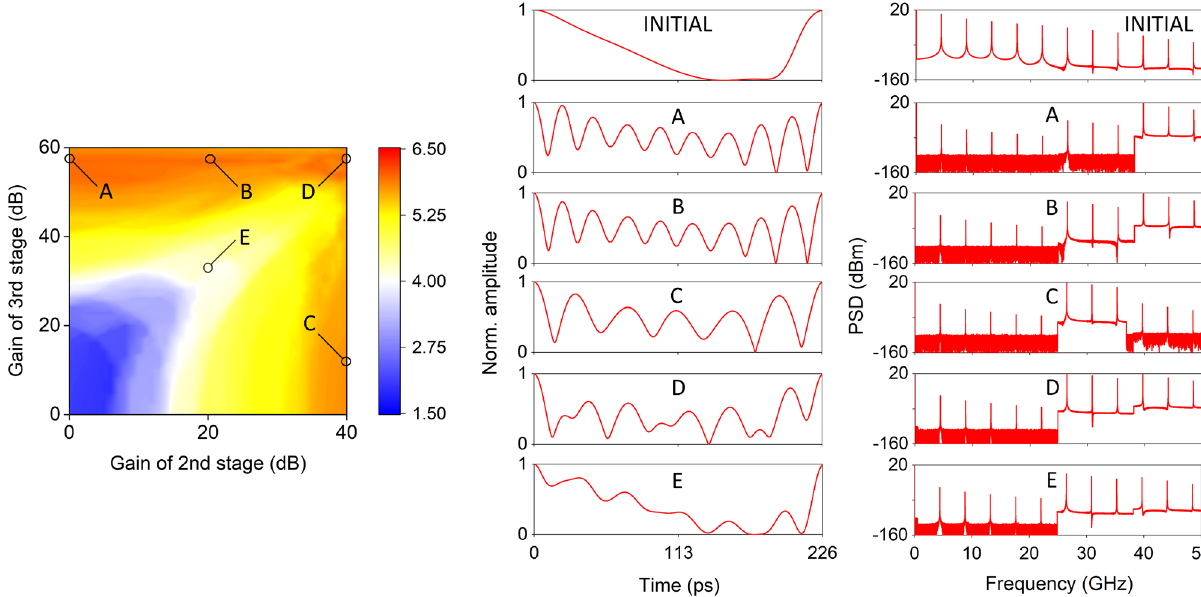
Figure 5. Left: Increment entropy PE inc of the repetitive patterns obtained for different amplification gain conditions in the second and the third spectral regime. Center: Normalized temporal persistence plots with 100 pattern repetitions for the initially emitted pattern by the SL-OF system and for the obtained patterns after electrical attenuation / amplification (cases A–E). In patterns A and B, fast oscillations are dictated by the stronger frequency components of the third amplification stage. In pattern C, the strongest frequency components of the second amplification stage result in a slower oscillating pattern. In pattern D, the strong amplification of both stages results in also faster oscillations but with suppressed peaks. In pattern E, moderate gain leads to only a limited variation of the initial pattern. The patterns are taken randomly from timeseries with 50000 consecutive patterns, including the first and the last one. The starting sample of each repetitive pattern is the one with the highest normalized amplitude. Right: Power spectral density of the corresponding patterns in a 50 GHz spectral range, as they are obtained from the physical